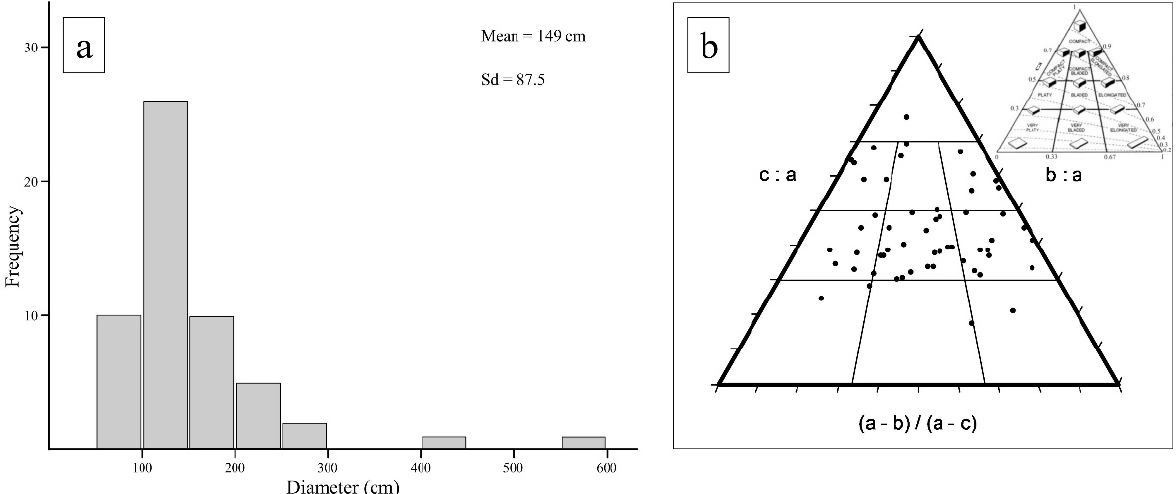
Figure 7. ( a ) Size-frequency distribution of boulders in the Bouanane site. ( b ) Boulders measured in the Bouanane site projected onto the Sneed and Folks (1958) diagram. The used classification for the boulders investigated in the study area is shown in Table S6 of the Supplementary Materials.